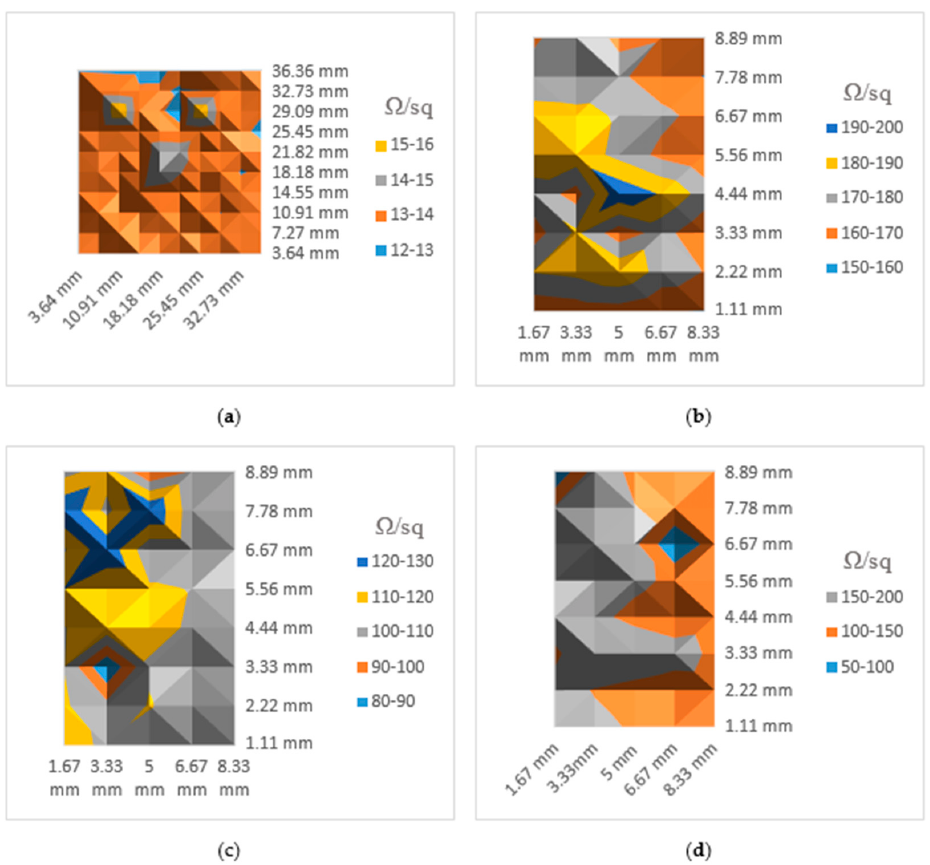
Figure 13. Results of automated sheet resistance measurement ( Ω /sq) using OS4PP: ( a ) Reference sample; ( b ) 50 nm ITO annealed 10 min; ( c ) 50 nm ITO annealed 20 min; ( d ) 50 nm ITO annealed 30 min.